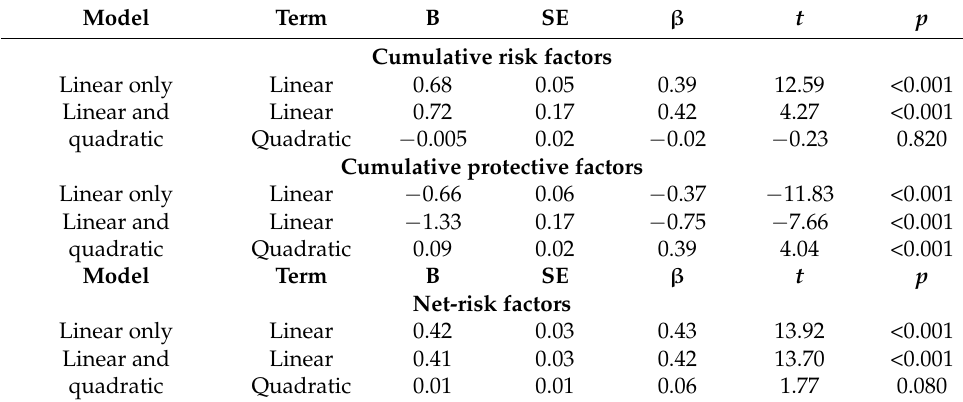
Table 4. Linear and Quadratic coefficients for curve